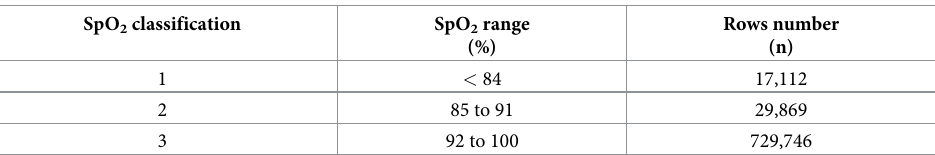
Table 1. Definition of SpO 2 class